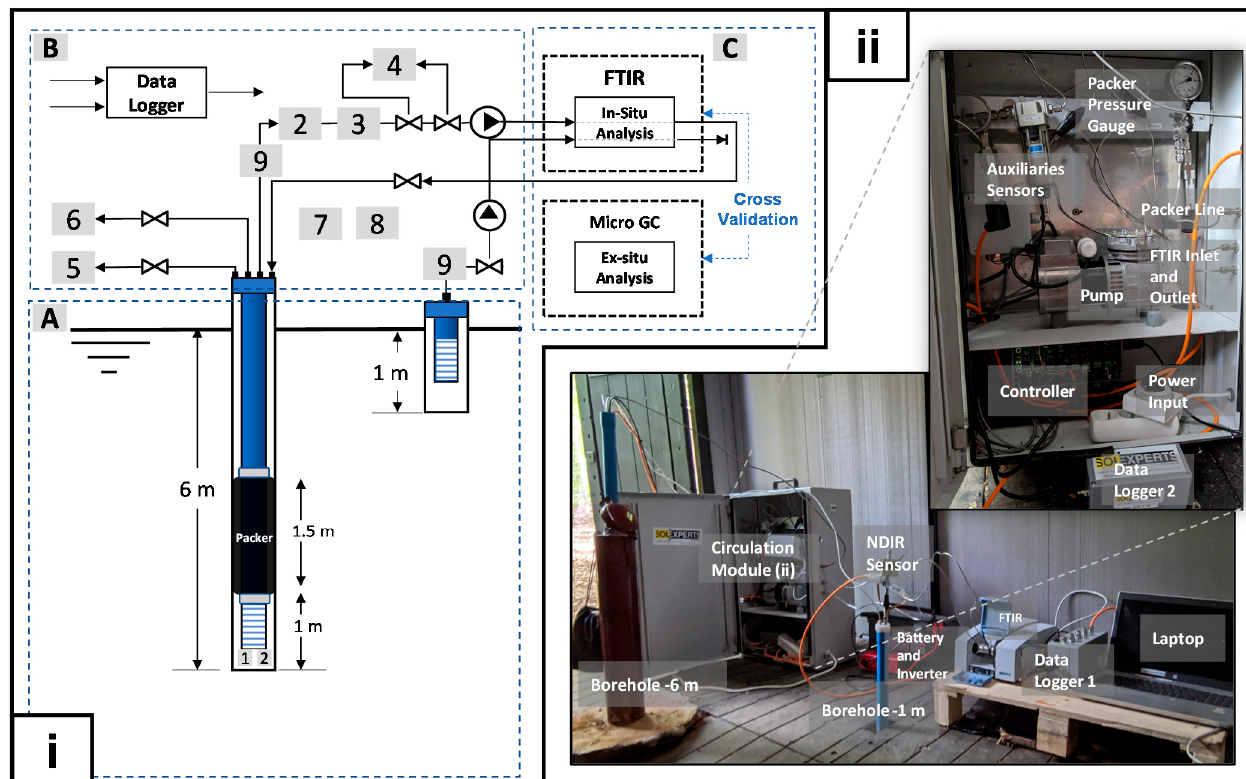
Figure 2. Monitoring concept for simultaneous and continuous gas measurement, including schematic diagram (i) and realistic view (ii) of monitoring infrastructure. The schematic diagram describes in more detail the process flow, which includes completion/boreholes ( A ), the circulation module ( B ), and calibrated FTIR Bruker Alpha with an additional GC sensor ( C ) for cross-validating. The circulation module consists of (1) temperature sensor, (2) pressure sensor, (3) water trap, (4) fluxmeter, (5) packer pressure, (6) borehole temperature indicator, (7) atmospheric temperature sensor, (8) atmospheric pressure sensor, (9) CO 2 NDIR sensor, and (10) soil moisture sensor.